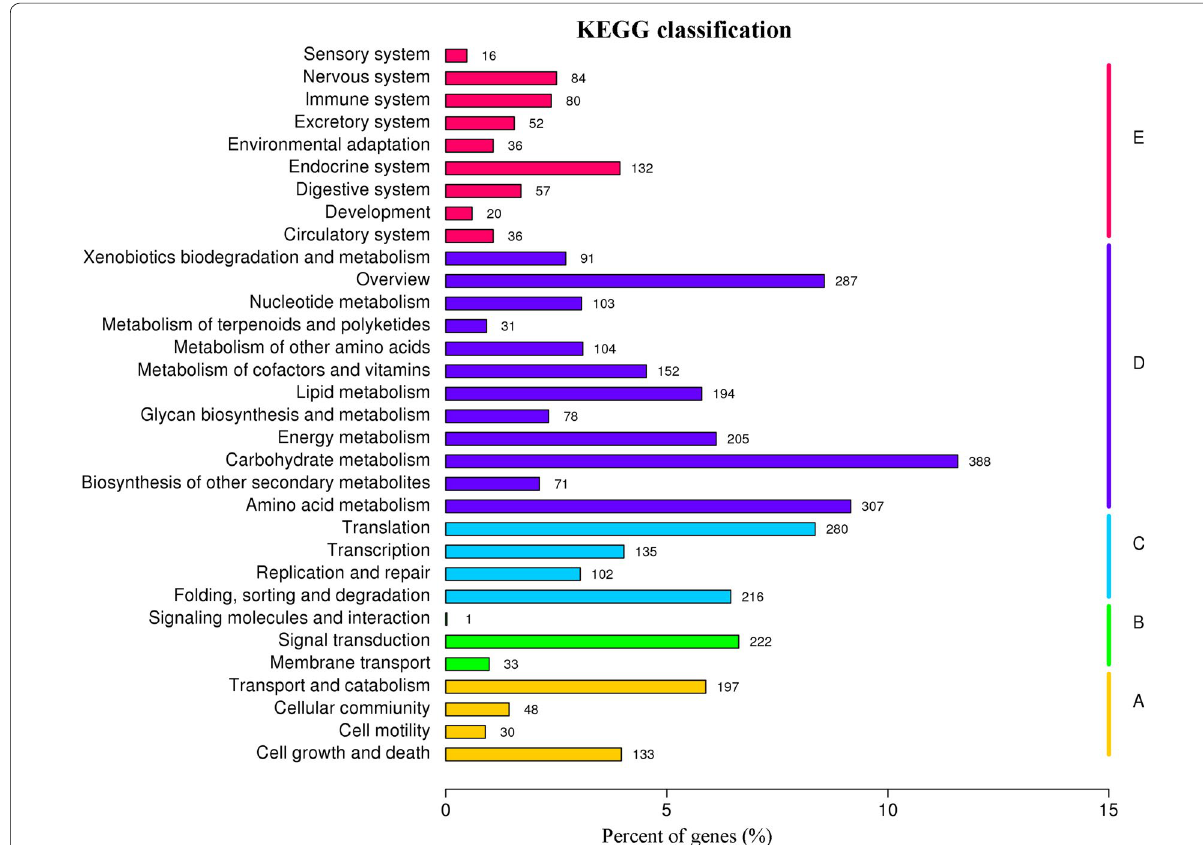
Fig. 4 KEGG classification of the C. cladosporioides MD2 unigenes. a Cellular processes; b environmental information processing; c genetic informa‑ tion processing; d metabolism; e organismal systems. The numbers on the column represented the estimation of unigenes within the